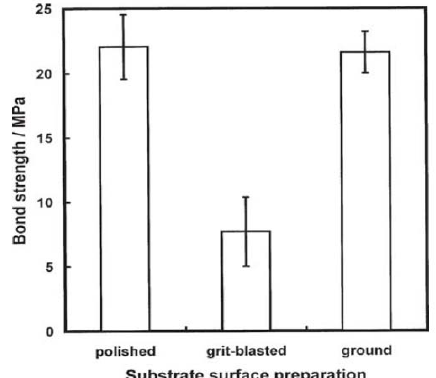
Figure 9: Bar chart showing the effect of substrate condition on the bond strength of deposits sprayed at 29 bar gas pressure using CTi powder(course powder) (error bars represent the standard error of the